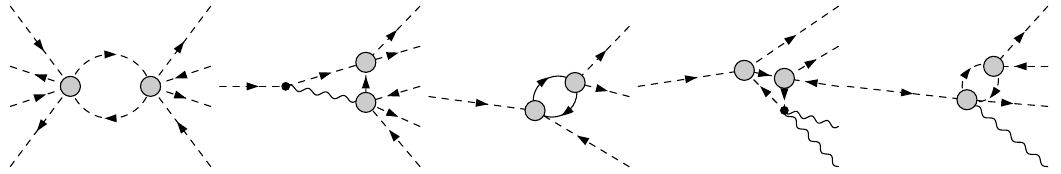
Figure 1: Example diagrams for the renormalisation of operators in classes φ 8 (first), φ 6 D 2 (second), φ 4 D 2 (third), X 2 φ 4 (fourth) and X φ 4 D 2 (fifth). The gray blobs represent dimension-six